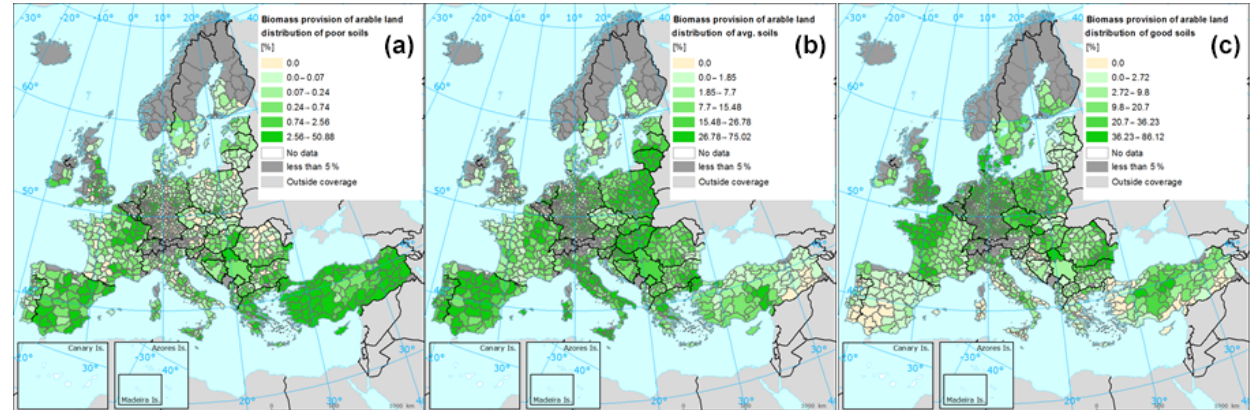
Figure 4. Distribution of soils according to their potential for biomass production on arable land: proportions of poor (a) , average (b) , and good (c) soils (in % of the total NUTS-3 region area). Legend shows the shares (%) from low (light green) to high (dark green), “0” (light yellow), no data (white), less than 5% (dark grey), and outside data coverage (light grey). “Less than 5%” means that the total area of arable land is smaller than 5%. Note that the same colours might represent different percentages as quantiles were used during the map production. Ranges are given between 0 and 50.88% (a) , between 0 and 75.02% (b) , and between 0 and 86.12% (c) .